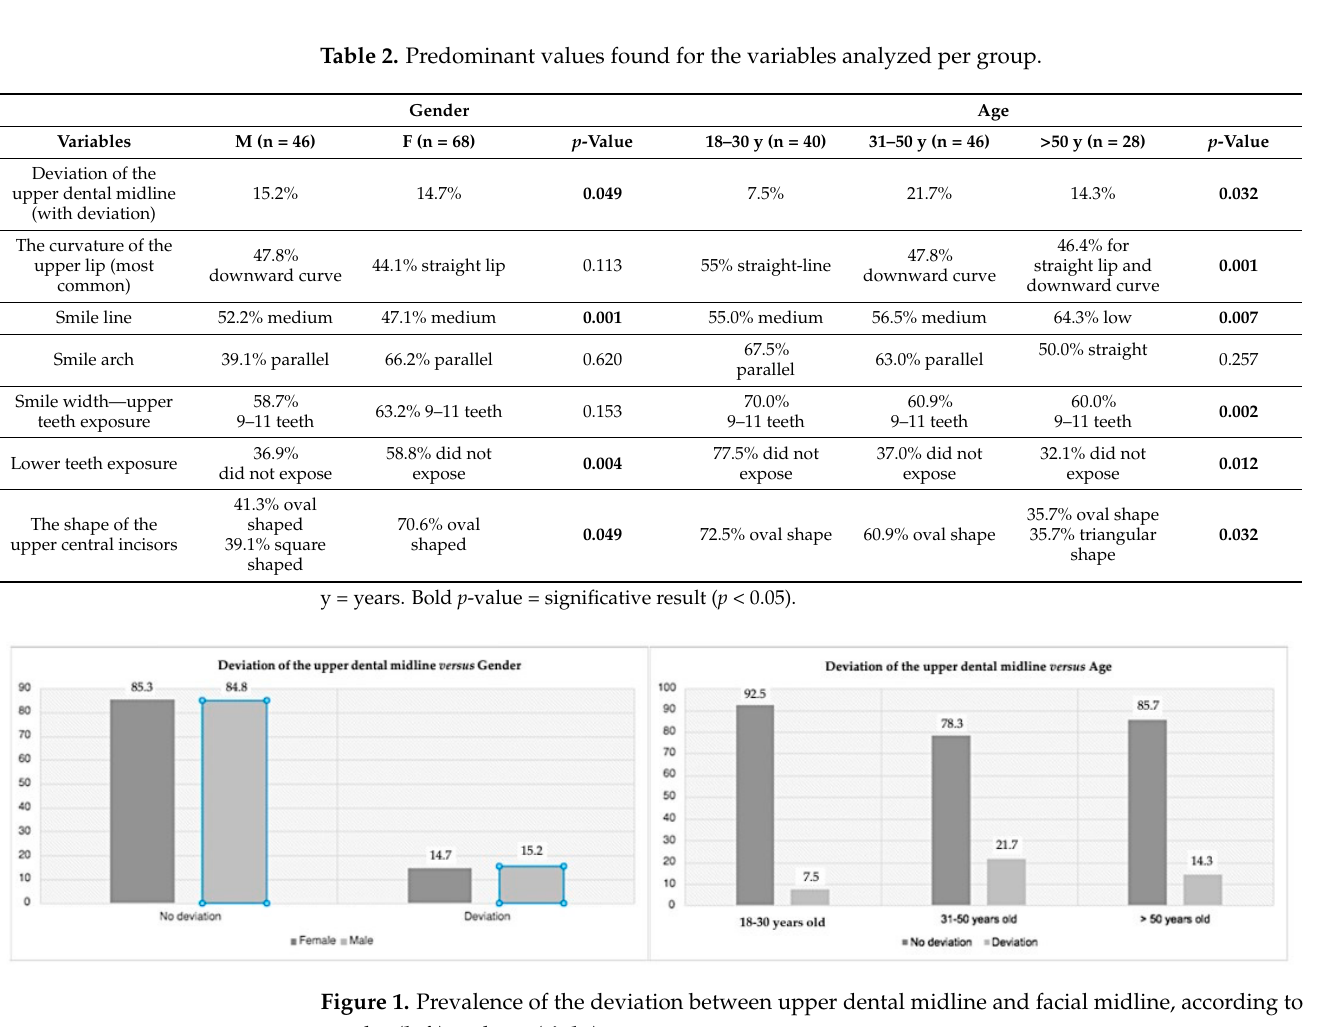
Figure 3. Prevalence of the smile line according to gender ( left ) and age ( right ). The smile arch and width were the other two parameters associated directly with the smile. Therefore, only the smile arch had significant statistical results for gender ( p = 0.001) and age ( p = 0.007) (Figures 4 and 5). The parallel smile arch was the most prevalent (63 patients, 55.3%) in contrast to the reverse arch, which was the least prevalent (14%). In 45 women (66.2%), a parallel smile arch was found, and only one woman (1.5%) had a reverse smile arch. Oppositely, 39.1% of men had a parallel smile arch, and 32.6% had a reverse smile arch. In addition, the prevalence of the type of arch changes with age, with a parallel smile arch present in around 65% of the participants up to 50 years old, while 50% of the over 50-year-olds had a straight arch. Up to 50 years old, parallel smile arch was the most observed (more than 60%) and reverse smile arch the least (around 10%). Only for the sample with more than 50 years old, there was prevalence of straight smile arch (50.0%). As mentioned above, smiling with upper teeth exposure (Figure 5) did not have sta- tistically significant results either for gender or age (respectively, p = 0.620 and p = 0.257). In both genders, between 9 to 11 teeth exposed was more prevalent, which was similar for all the age groups; 12 or more teeth exposed was the least observed. On the other hand, when analyzing the lower teeth exposure (Figure 6), a significant correlation was found with aging ( p = 0.002) but not with gender ( p = 0.153). Older patients were significantly associated with the exposition of the lower teeth. In all groups evaluated, the non-expo- sure of the lower teeth was the most prevalent, 57 (50.0%) of the sample did not exposure the lower teeth, 21.9% exposed to 4 to 6 teeth, 12.3% exposed between 7 to 9 teeth, and 15.8% had exposure of 10 or more teeth. When comparing this variable with age, 31 younger individuals (77.5%) did not expose their lower teeth when smiling; for the group between 31 and 50 years old, 37.0% did not expose their lower teeth, while 12 individuals (26.1%) exposed between 4 and 6 teeth and 21.7% exposed 10 or more lower teeth when smiling; over 50 years, 32.1% did not expose their lower teeth, 25.0% exposed between 4 and 6 teeth, and 25.0% exposed 10 or more lower teeth when smiling. The last variable studied was the shape of the maxillary central incisors (Figure 7). It had significant results for gender ( p = 0.004) and age ( p = 0.012). Sixty-seven individuals